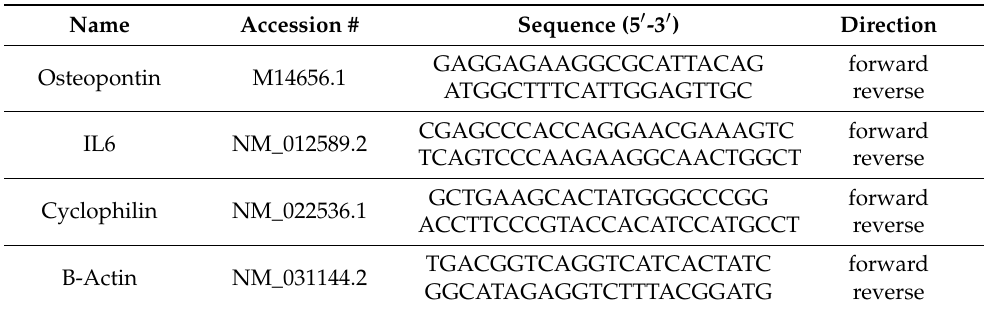
Table 1. List of genes and primers used for qPCR. Common name is shown in the first column, the NCBI accession number is shown in the second column. The nucleotide sequence (5 (cid:48) -3 (cid:48) direction) of each primer pair is shown in the third column, and the primer position (forward/reverse) is indicated in the fourth column for each